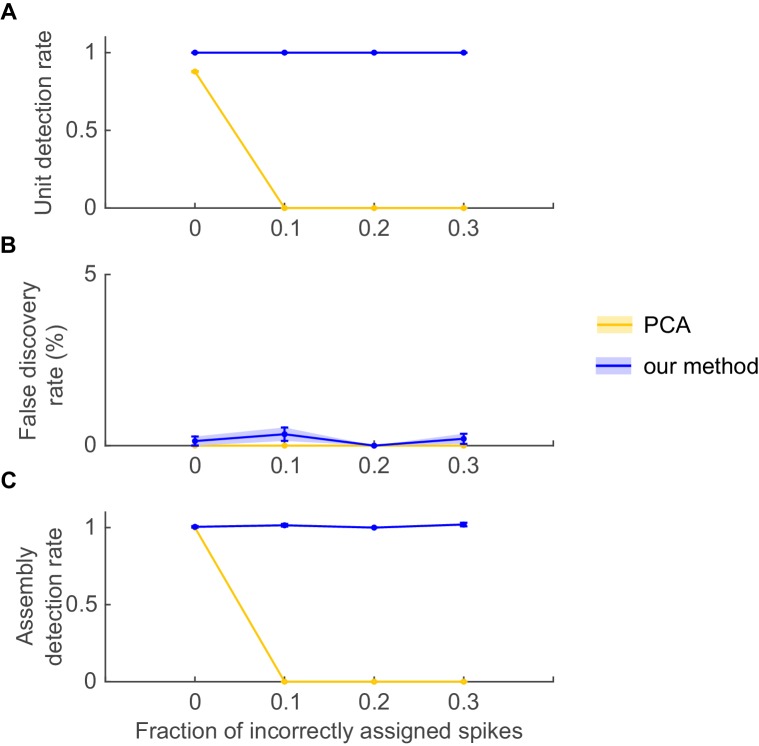
Stability of PCA solutions to degradation in assembly patterns.Even under fully stationary conditions, PCA may completely fail to detect assembly patterns if degraded by spike assignment noise. Simulation setup was as in Appendix 1—figure 2, with the exception that no non-stationary step changes were included, i.e. spike trains were completely stationary. PCA methods were implemented as in Appendix 1—figure 2 (see ref. [Euston et al., 2007]). Noise in the form of spike misattributions or spike failures was introduced by randomly removing a fraction of assembly spikes from each spike train. (A) Fraction of correctly detected assembly units as a function of the proportion of spike assignment errors, (B) fraction of units incorrectly assigned to an assembly (false discovery rate), and (C) fraction of correctly detected assemblies (out of the total number of embedded assemblies), for PCA (yellow curves) and our method (blue curves). Error bars = SEM, based on 50 independent simulation runs.